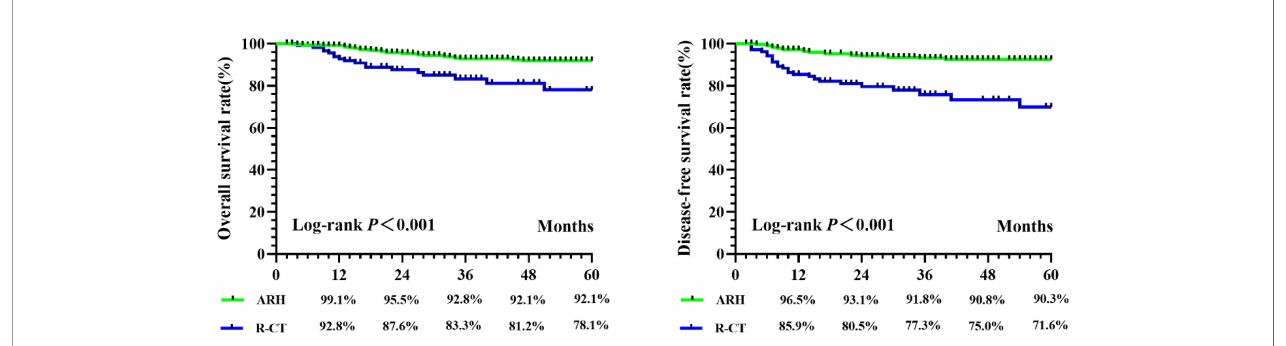
FIGURE 3 | The 5-year OS and DFS in ARH group and R-CT group after PSM.